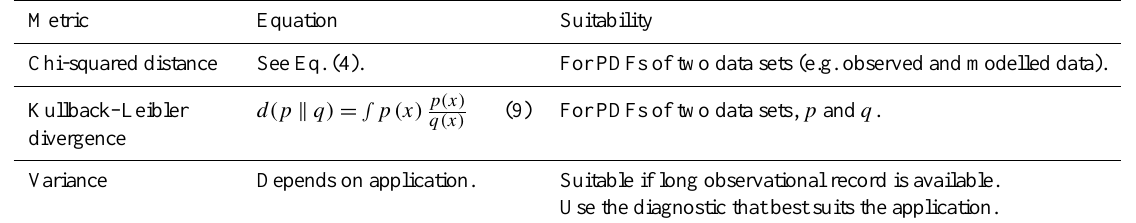
Table 3. Summary of Level 2 metrics. Metric